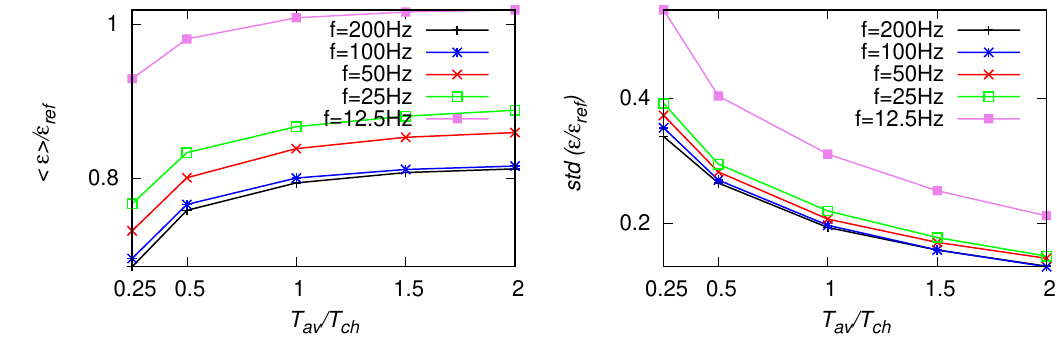
Figure 18. As in Figure 16, but for the fitting range f = [ 1 ÷ 5 ] Hz.